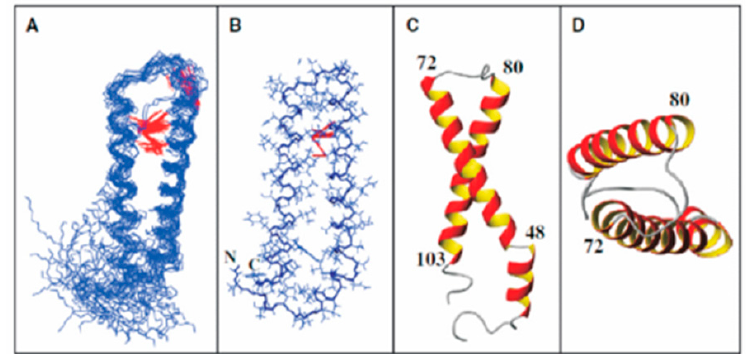
Figure 8. ( A ) Backbone representation of the ensemble of the 20 lowest energy conformers of Ste2p (G31-T110) superimposed over backbone atoms in the TM1-TM2 region comprising residues 39–103. Observed long-range NOE contacts are highlighted in red. ( B ) A single conformer from the ensemble additionally displaying the side chains. ( C ) Structure of a single conformer—view from the side of the membrane interior. ( D ) The same as C , but viewed from the cytoplasmic side. Taken with permission from [121].